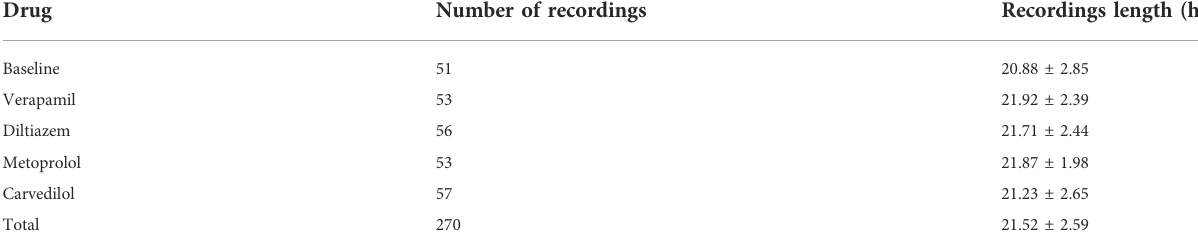
TABLE 2The numberofrecordingsandrecordinglength(mean±std)analyzedin this studyfollowing exclusion ofrecordingswithinsuf fi cientsignal quality, as described in Section 2.3. Drug Number of recordings